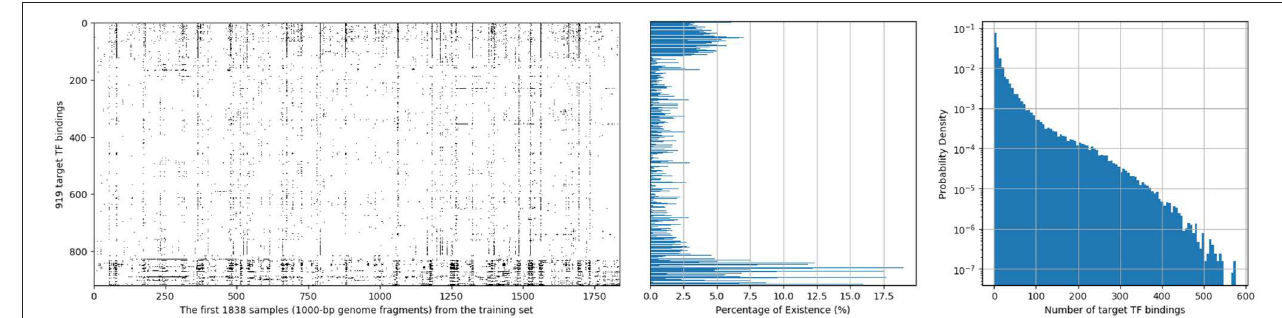
FIGURE 2 | Distribution of 919 target TF bindings for the first 1,838 samples extracted from the training set of population 4,400,000 (Left) ; Percentage of training samples that possess the corresponding TF binding for each target (Middle) ; and a histogram of numbers of target TF bindings that training samples possess (Right) .